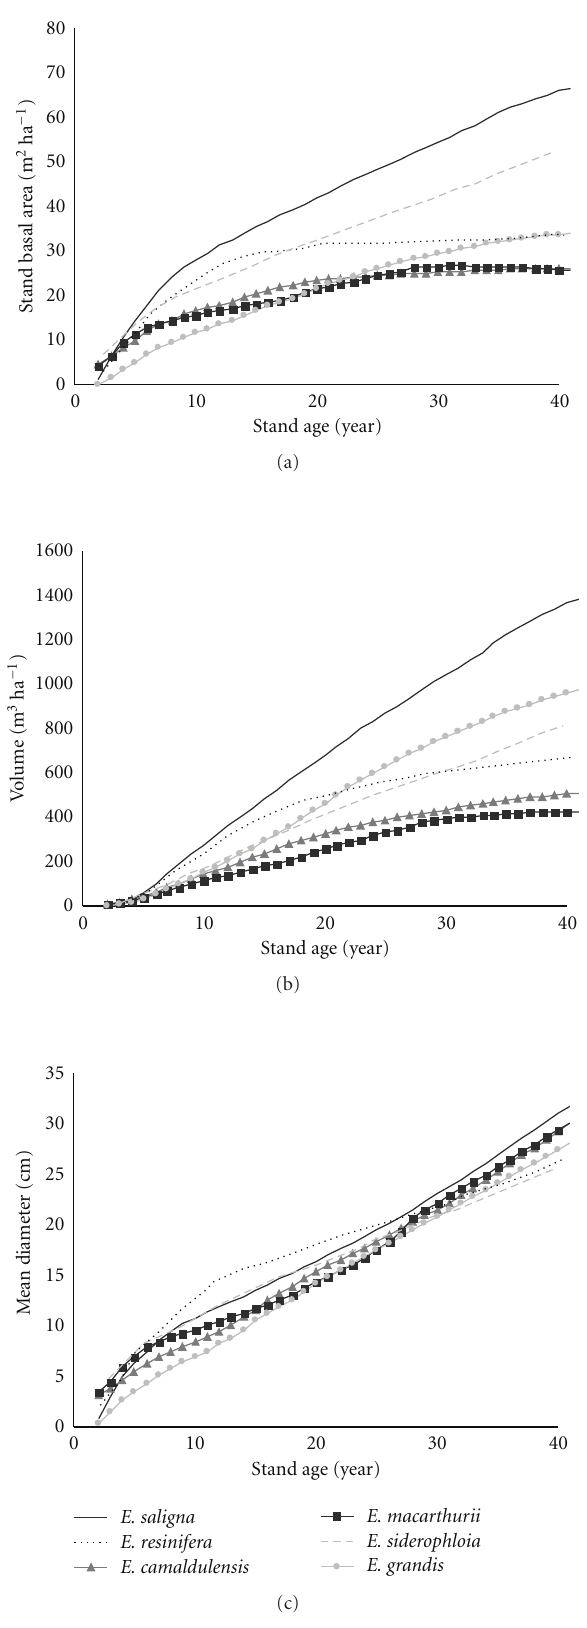
Figure 5: Volume, basal area, and mean diameter development of the analysed eucalypts in the Tchianga experiment.